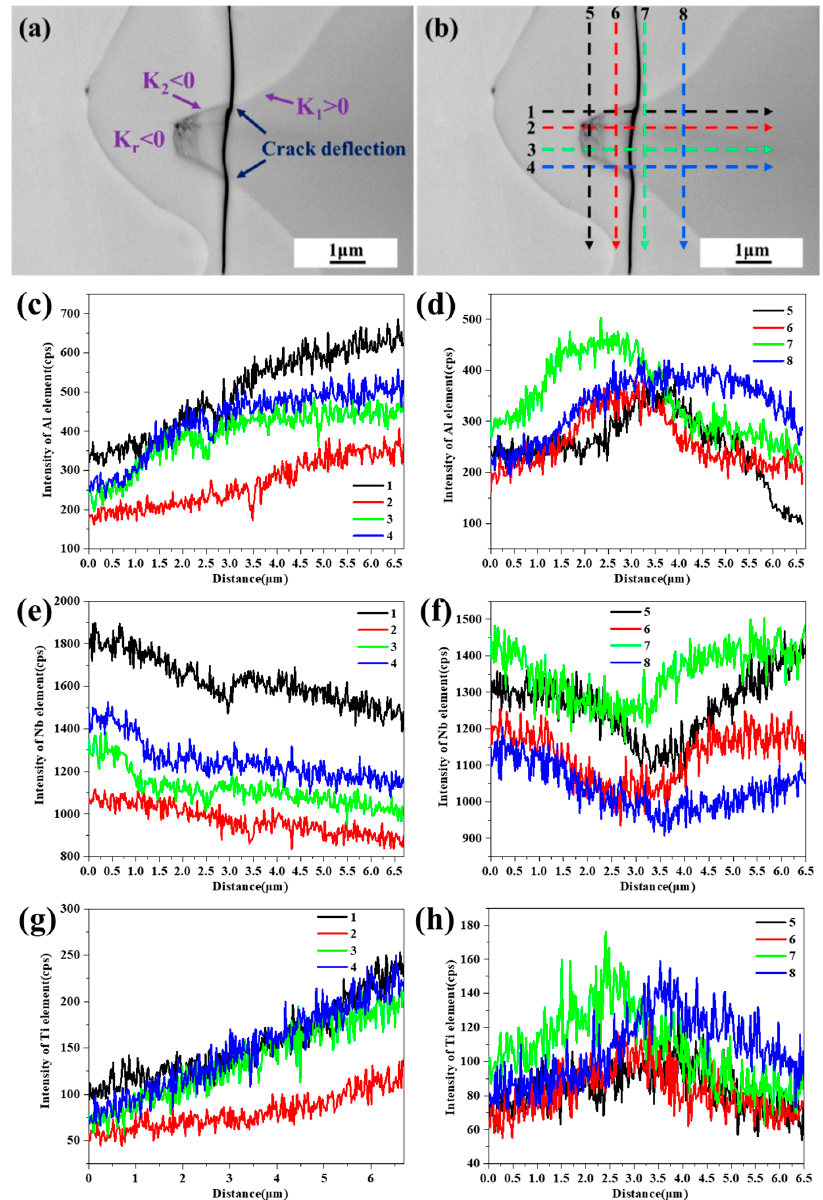
Figure 11. SEM micrograph of U-groove ( a ) and the relevant SEM-EDS line scanning in it ( b ), the relative content of Al, Nb and Ti along the dot line in ( b ) by SEM-EDS line scanning: ( c , d ) for Al, ( e ) and ( f ) for Nb, ( g ) and ( h ) for Ti.